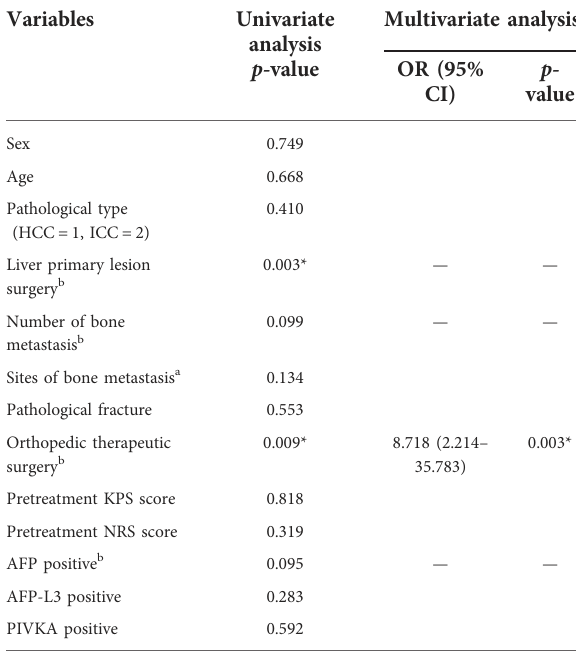
TABLE 4 The logistic regression to identify the in fl uence factors of greater KPS score